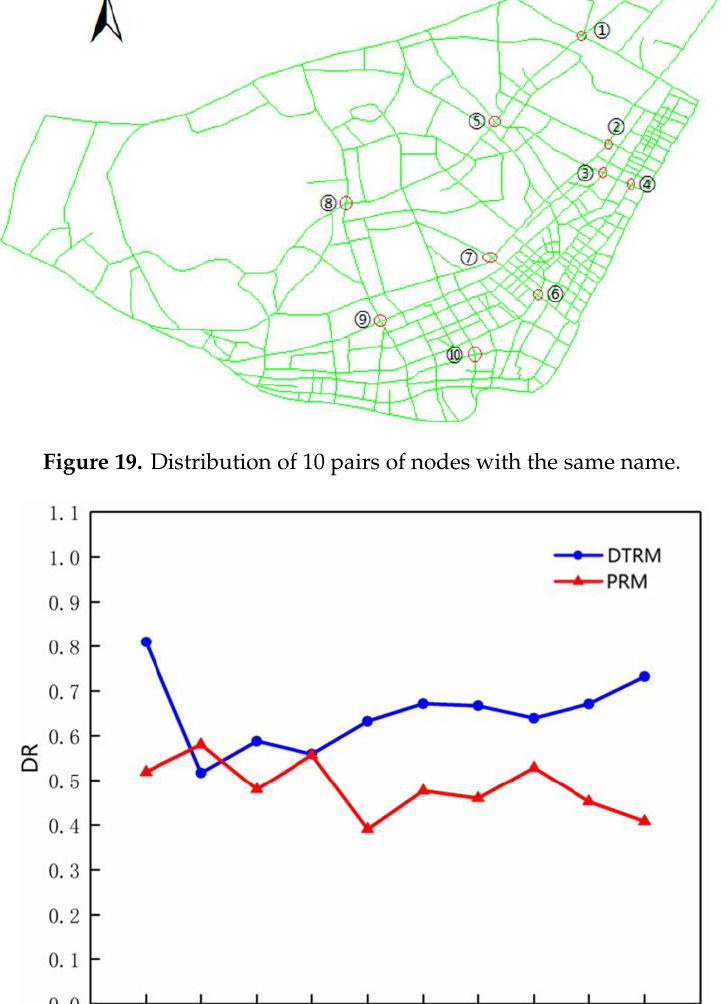
Figure 20. DR of DTRM and PRM.